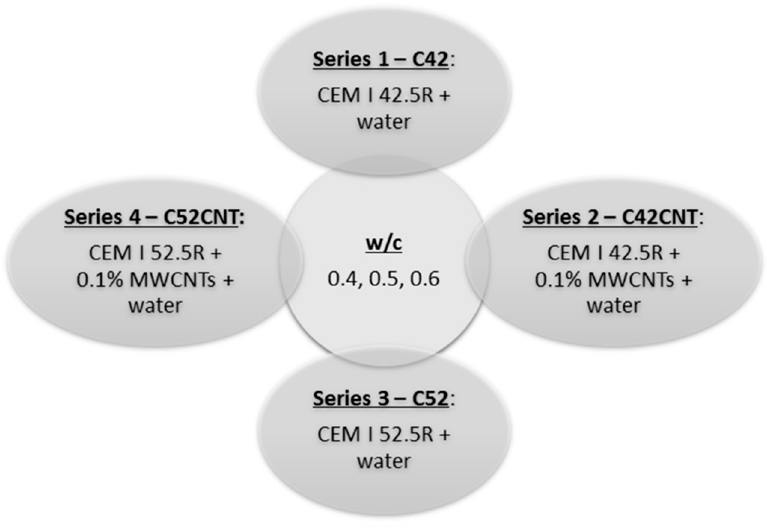
Figure 2. Designations and composition of the series.